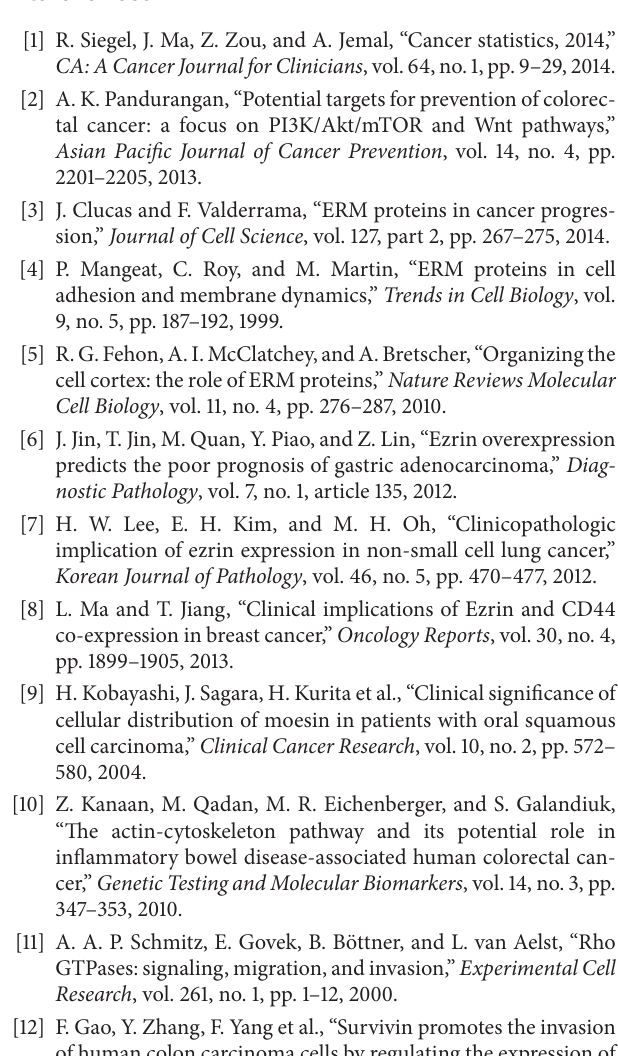
Figure 7: Diagram depicting the possible molecular mechanism of radixin in colon cancer cell invasion and